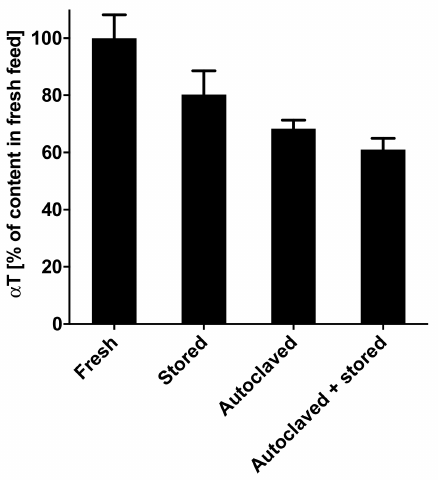
Figure 5. Mean total α -tocopherol ( α T) content (error bars represent standard error of the mean; n = 3) of stored (1 week at room temperature with 12 h light / dark cycle), autoclaved (20 min at 121 ◦ C), and autoclaved and stored rodent feed relative to fresh feed (not stored, not autoclaved, directly extracted and analysed). The C1000 rodent feed used was from Altromin Spezialfutter GmbH & Co (KG, Lage,